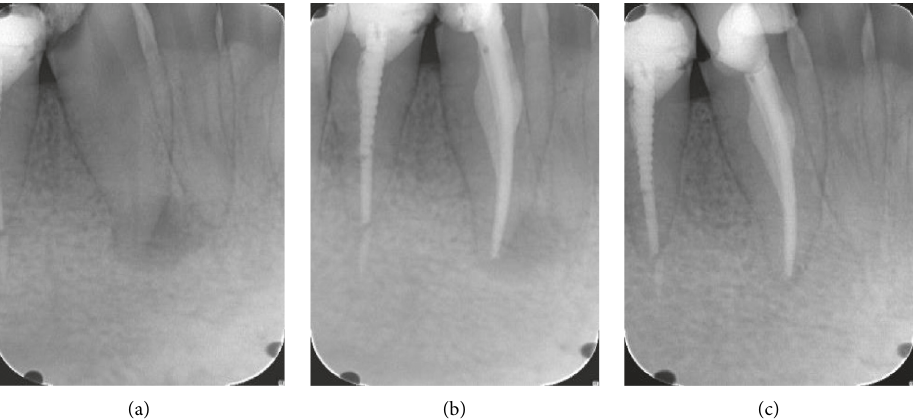
Figure 2: Medium-size lesion in initial treatment without extruded sealer periapical lesion. A:diagnostic X-ray; B: final obturation; C: 24 month